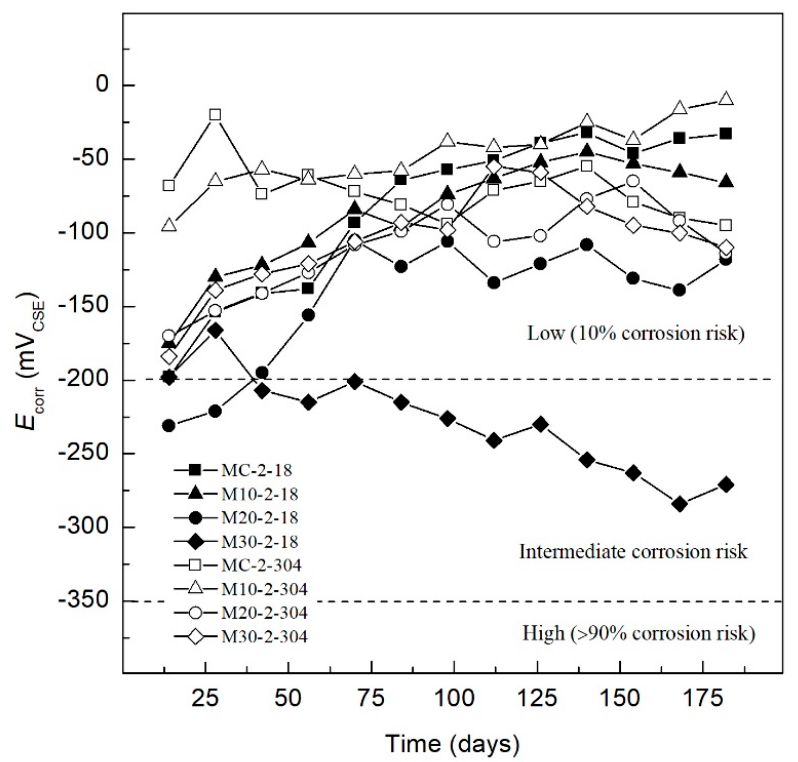
Figure 3. E corr of specimens exposed in 3.5 wt.% MgSO 4 solution.